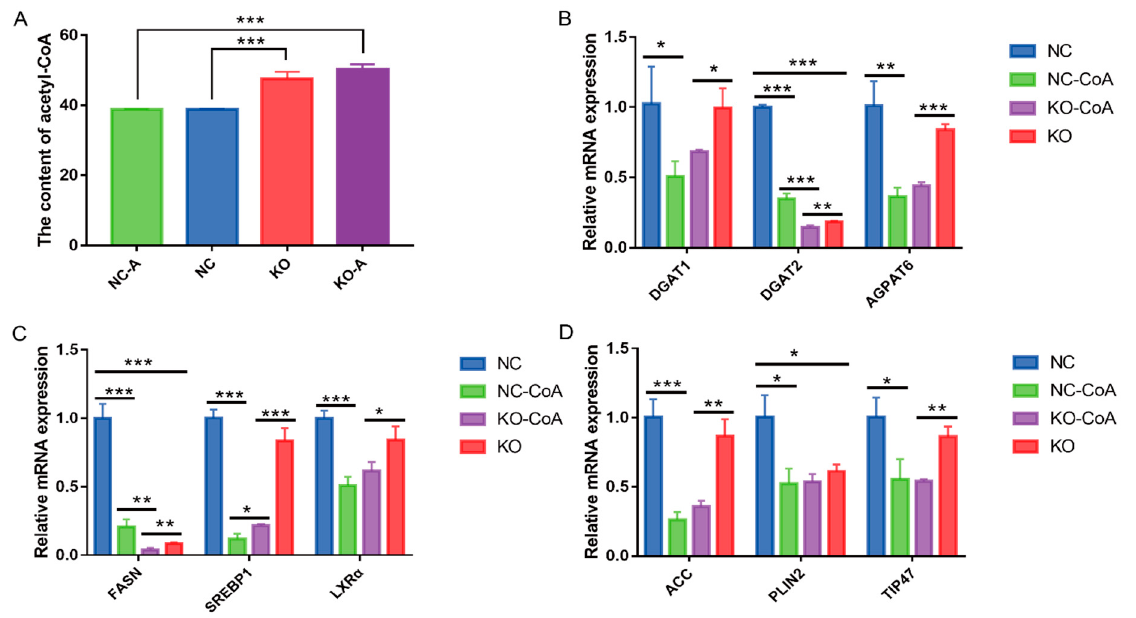
Figure 6. Acetyl-CoA suppresses the fatty acid anabolism. ( A ) Effect of MAT knockout on intracellular acetyl-CoA. NC-A—the control group added with acetyl-CoA; KO-A—the knockout group added with acetyl-CoA. ( B – D ) Effect of acetyl-CoA treatment on genes related to fatty acid synthesis. Values are means ± SEM for three independent experiments. * p < 0.05, ** p < 0.01, *** p < 0.001.